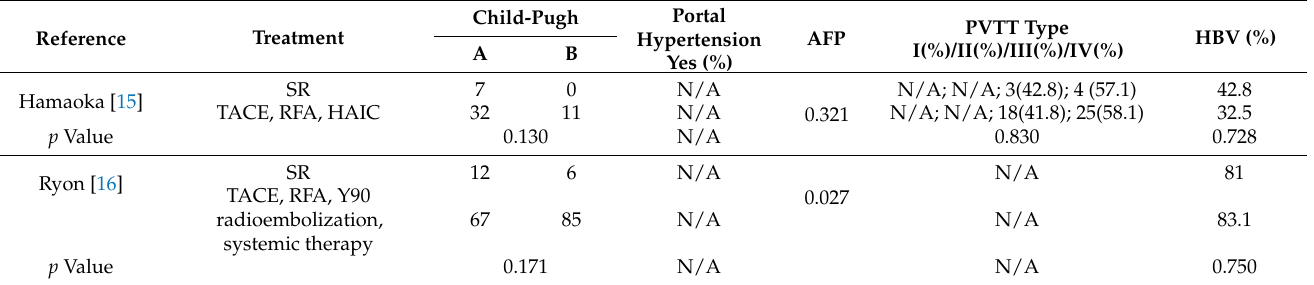
Table 2. Characteristics of the